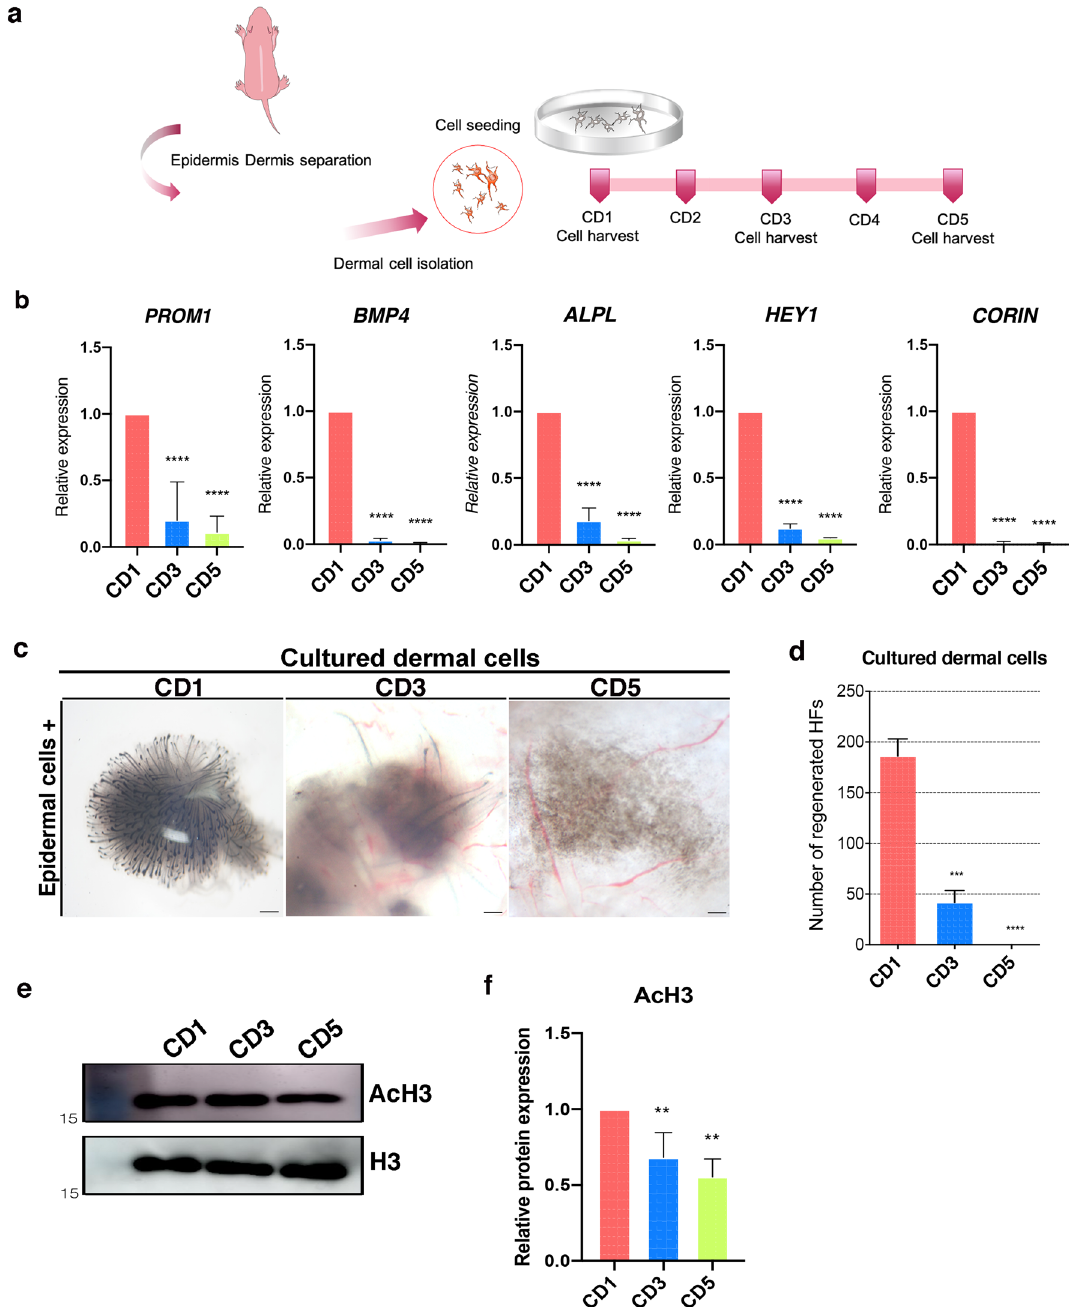
Figure 1. HF inductivity and histone H3 acetylation in cultured DCs from postnatal mice. ( a ) Schematic describing DC preparation and culture. ( b ) Relative expression of signature genes for HF inductivity in cultured DCs at CD1, CD3, and CD5. Data are shown as the mean ± S.E.M. (*, P < 0.05; **, P < 0.01; ***, P < 0.001; ****, P < 0.0001) (n = 6). ( c ) HF reconstitution assay using CD1, CD3, and CD5 DCs and freshly isolated epidermal cells (scale bar 500 μm), and ( d ) the number of reconstituted HFs as determined by ImageJ (n = 5). ( e ) Immunoblots against acetylated histone H3 and total H3 for each day of culture (n = 5). ( f ) Relative histone H3 acetylation expression graph shown in ( e ). Data are represented as the mean ± S.E.M. (n = 4) (**, P < 0.01). CD, culture day; DCs, dermal cells; HFs, hair